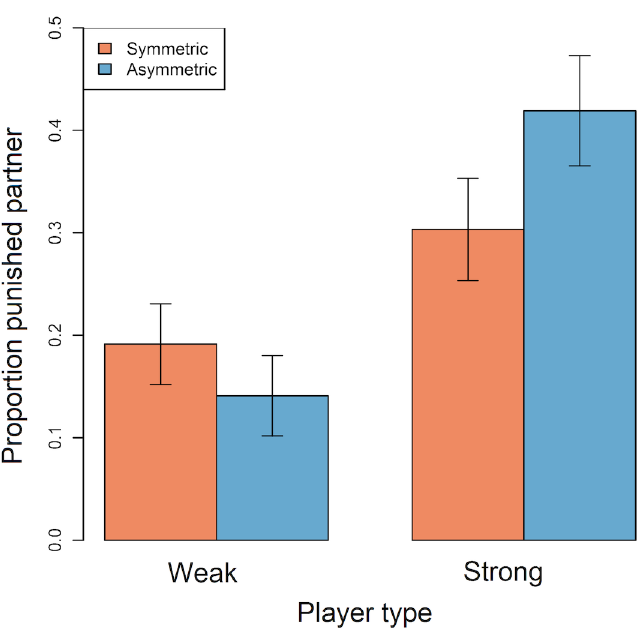
Fig 3. Barplot showing the mean (+/- SEM) proportion of instances in which weak and strong players punished their partner in symmetric and asymmetric games. Data were restricted to instances where the focal player chose a higher cooperation level than their partner and exclude rounds where either player opted out. Plots are generated from raw